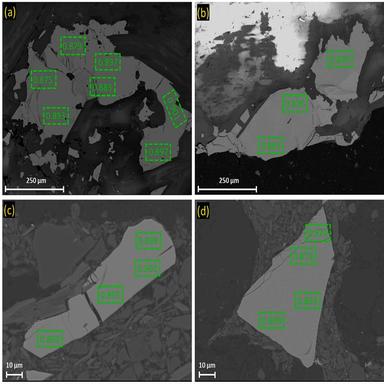
The SEM images of the ore and flotation concentrate samples acquired using both BSE and EDS detectors. Panels (a) and (b) depict two different zones of the examined ore sample and represent the same areas shown in panels (a) and (d) in Panels (c) and (d) depict two different zones of the examined flotation concentrate sample and are equivalent to panels (a) and (d) in